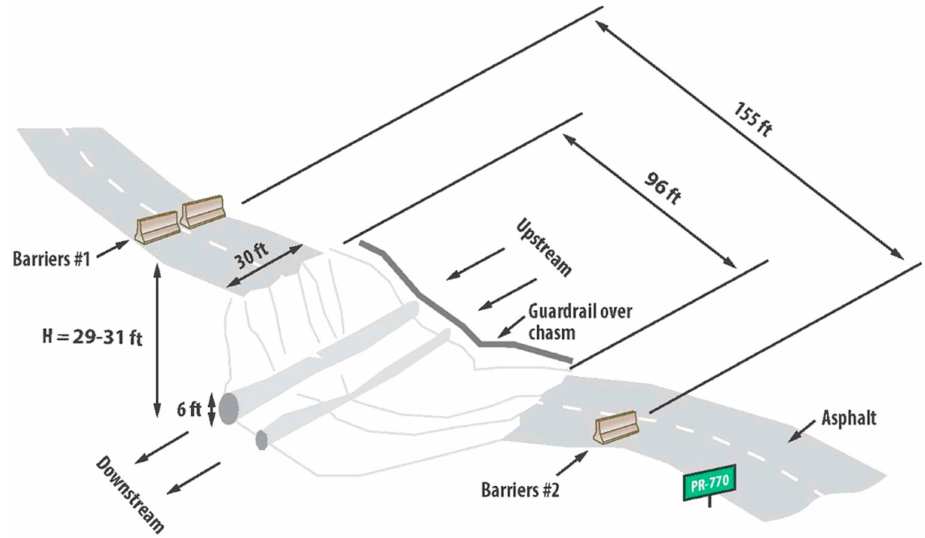
Figure 3. Notional sketch of the important features of a roadway assessment. These sketches are often hand-drawn by field survey teams. Specifically, this sketch is of a roadway wash-out of PR-770 near Barranquitas, Puerto Rico.